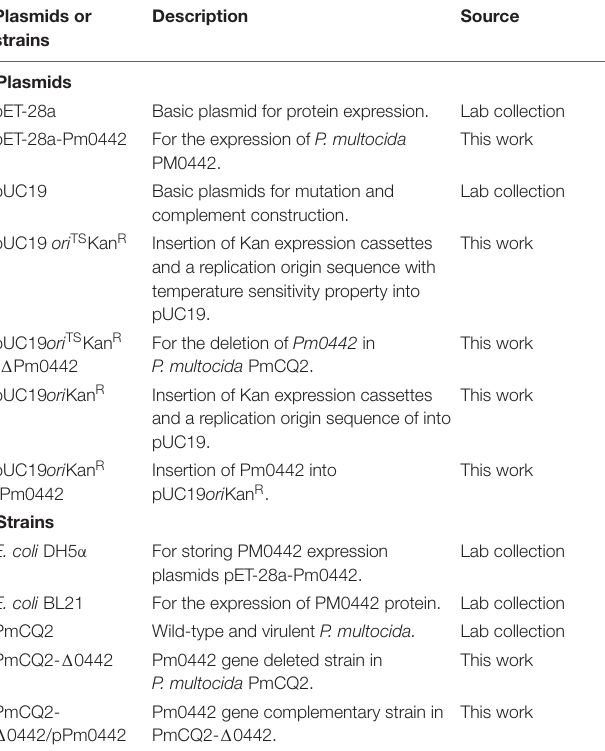
TABLE 2 | Bacterial strains and plasmids used in this